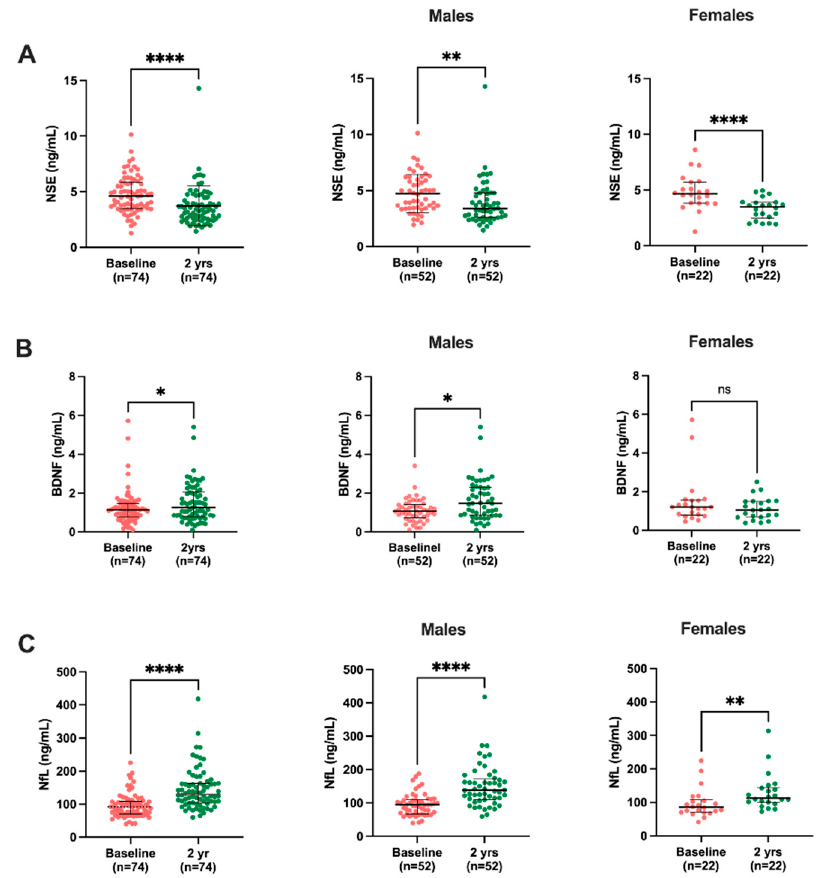
Figure 1. Comparison of biomarker ( A ) NSE, ( B ) BDNF, and ( C ) NfL levels at the baseline and two-year follow-up among KT patients. Results are presented as the median and IQR. The differences between baseline and two years post-KT were analyzed using the Wilcoxon paired test. * p < 0.05, ** p < 0.01, **** p < 0.0001. Table 2. Sex-divided analysis of NSE, BDNF, and NfL between male and female patients at baseline and two years